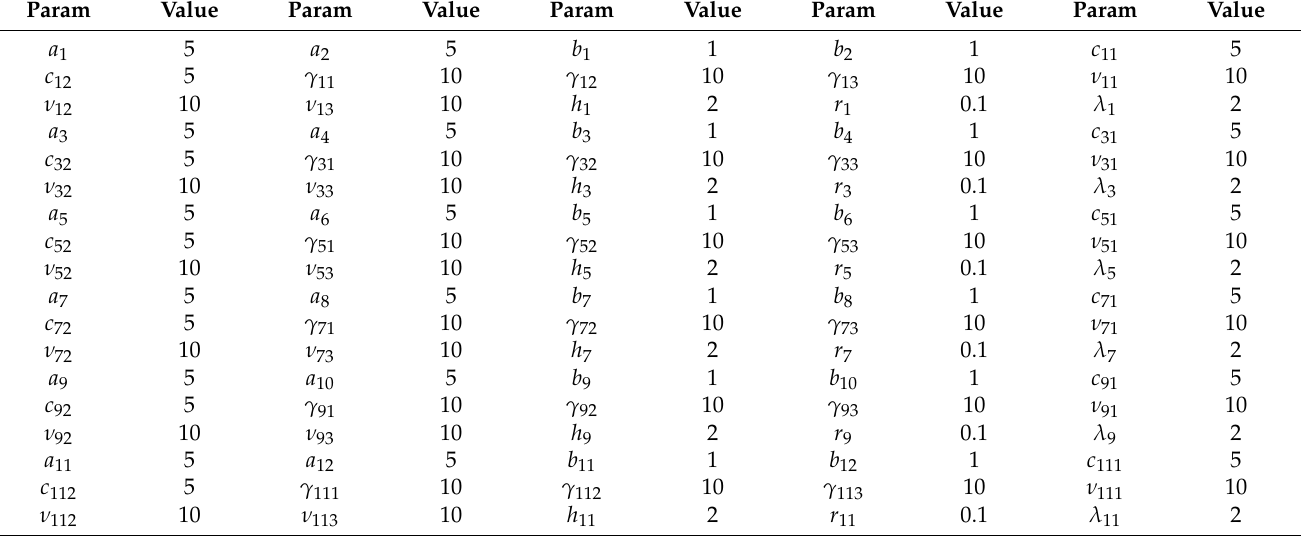
Table 2. Values for the selectable parameters in the proposed